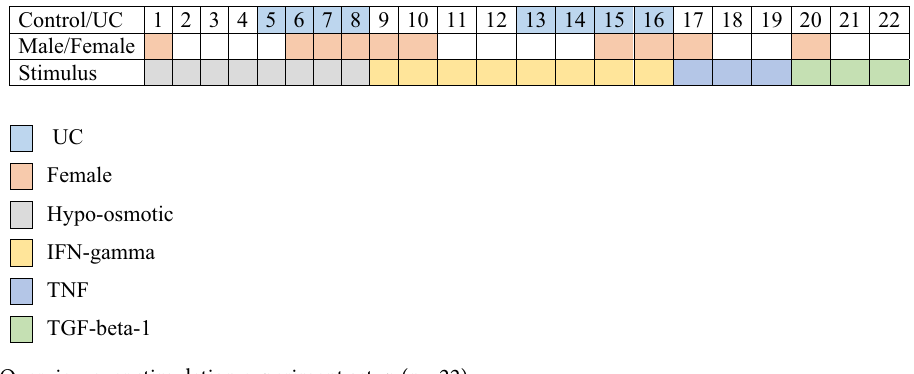
Table 3. Overview over stimulation experiment setup (n =